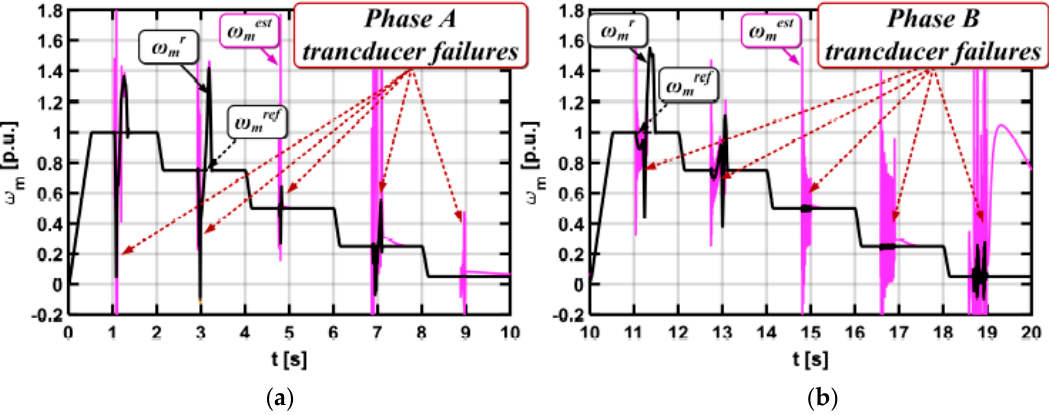
Figure 10. Measured, real, and estimated induction motor speed during the neural network training process (for phase A transducer failures ( a ) and for phase B transducer failures ( b )).